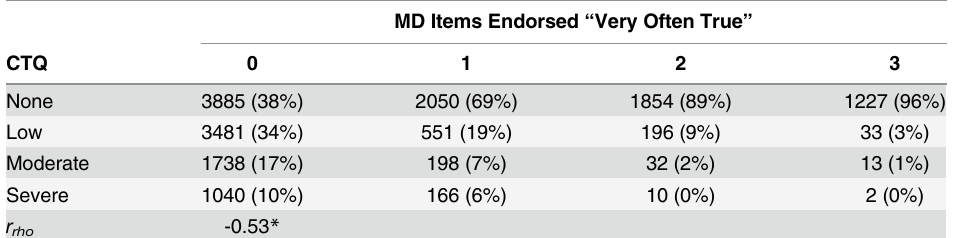
Note: Listwise deleted Spearman correlations (r rho ) are reported for the associations between the dichotomous grouping variable (community = 0; clinical = 1) and continuous CTQ total scores. MD = Minimization-Denial subscale total score; CTQ = Childhood Trauma Questionnaire total score. Total sample size is less than 19,652 due missing data and listwise